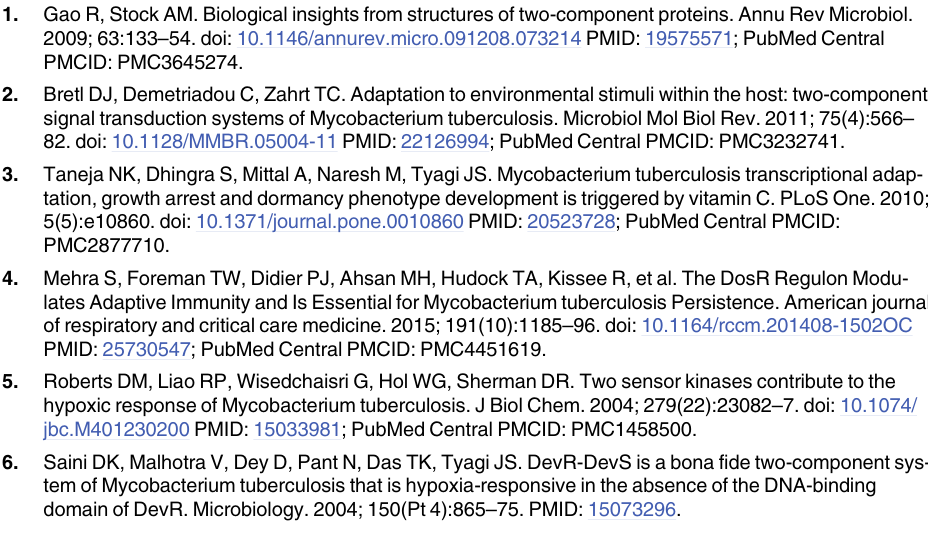
S3 Table. Oligonucleotide primers used for qPCR.